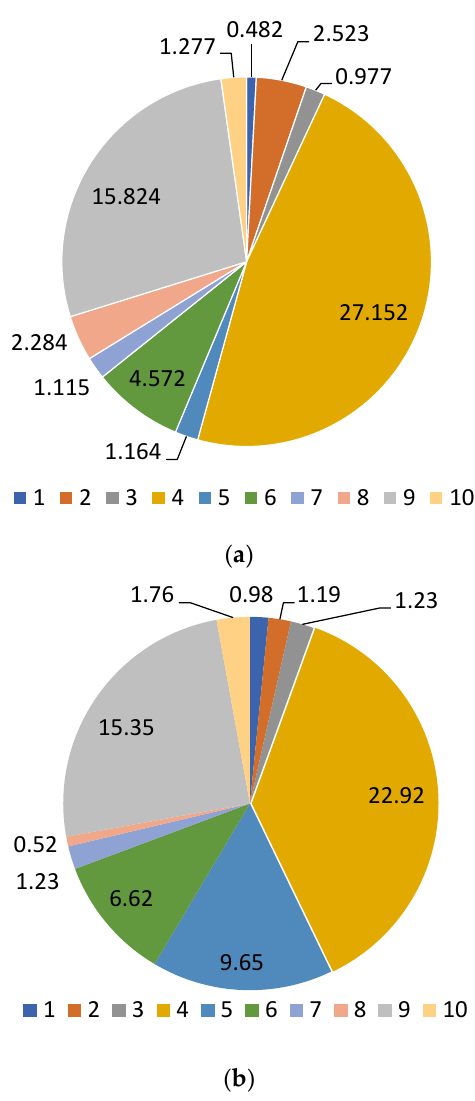
Figure 9. Percentage of identified BAS yield in extract samples ( a ) extraction for 25 min with US treatment; ( b ) extraction for 25 min without US treatment: 1 — 3,4-dihydroxybenzoic acid; 2 — chlorogenic acid; 3 — hyperoside; 4 — quercetin-3D-glycoside; 5 — apigenin; 6 — cachetin; 7 — caffeic acid; 8 — rutin; 9 — astragalin; 10 — rosmarinic acid.